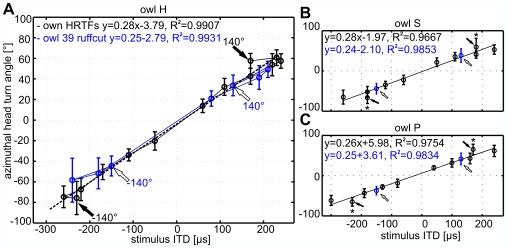
Prediction of azimuthal head-turns from the ITD.The ITD contained at 0° stimulus elevation in the HRTFs of (A) owl H, (B) owl S, and (C) owl P were plotted against the azimuthal head-turn angle in degree. A linear regression (dotted line) through all head-turn angles shows that the owls responded well to the ITD in the HRTFs within the frontal field (≤±60°). Linear equations and goodness of fit (R2) of the regression are stated in each panel. With individualized HRTFs at ±140° (black arrows), however, the head-turn angles significantly deviated from the regression line (Mann-Whitney test, p<0.05).